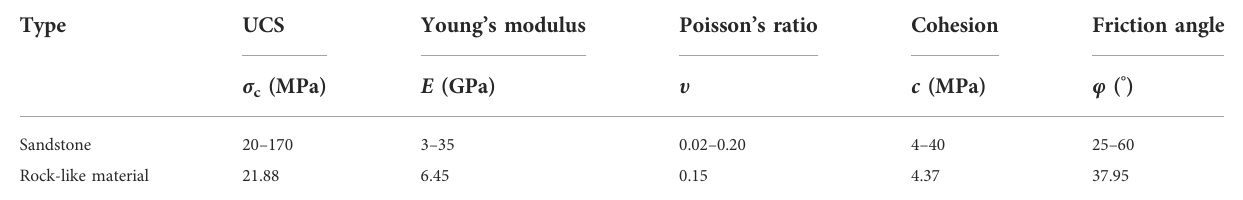
TABLE 1 Mechanical properties of the experimental material.